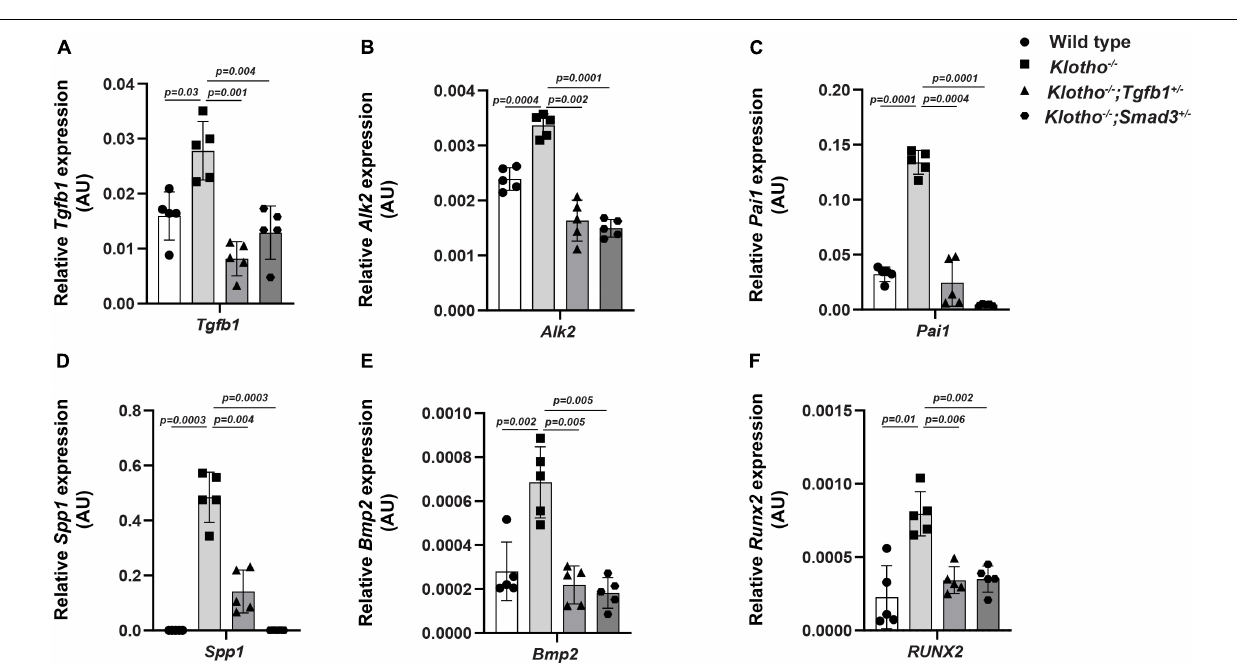
FIGURE 5 | Effect of partial genetic deletion of Tgfb1 and Smad3 on key genes involved in TGF β and BMP signaling, and AV calcification. The qPCR analysis of selected genes in micro-dissected pooled tissue samples representing AV leaflets and hinge and aortic annulus of wild-type, Kl − / − , Kl − / − ;Tgfb1 ± , and Kl − / − ;Smad3 ± mice. Expression levels of Tgfb1 (TGF β ligand) (A) , Alk2 (BMP Type I receptor) (B) , Pai1 (TGF β target gene) (C) , Spp1 (calcification marker) (D) , Bmp2 (BMP ligand) (E) , and Runx2 (osteoblast differentiation marker) (F) were quantified. Triplicate samples from each of the five different biological replicates ( n = 5) were analyzed. Quantitative data are shown as mean ± SD ( n = 5). Two-sided Student’s t -test (unpaired) was used. Significant comparisons are indicated on the top of each